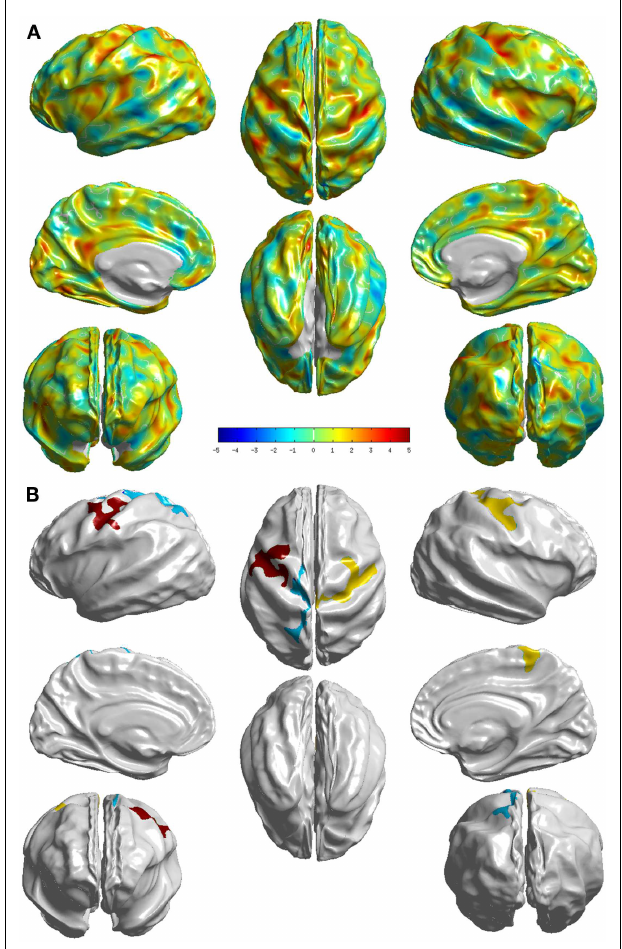
FIGURE 3 |Visualization of the differences between the two groups NC and md-aMCI . (A) T -statistic values displayed at each vertex (B) the set of clusters, which survived the multiple-comparisons test (cluster-wise significance), each colored differently.We can see that they exhibit significant differences, in many cortical areas compared to the differences noticed between NC and sd-aMCI as shown in Figure 2B